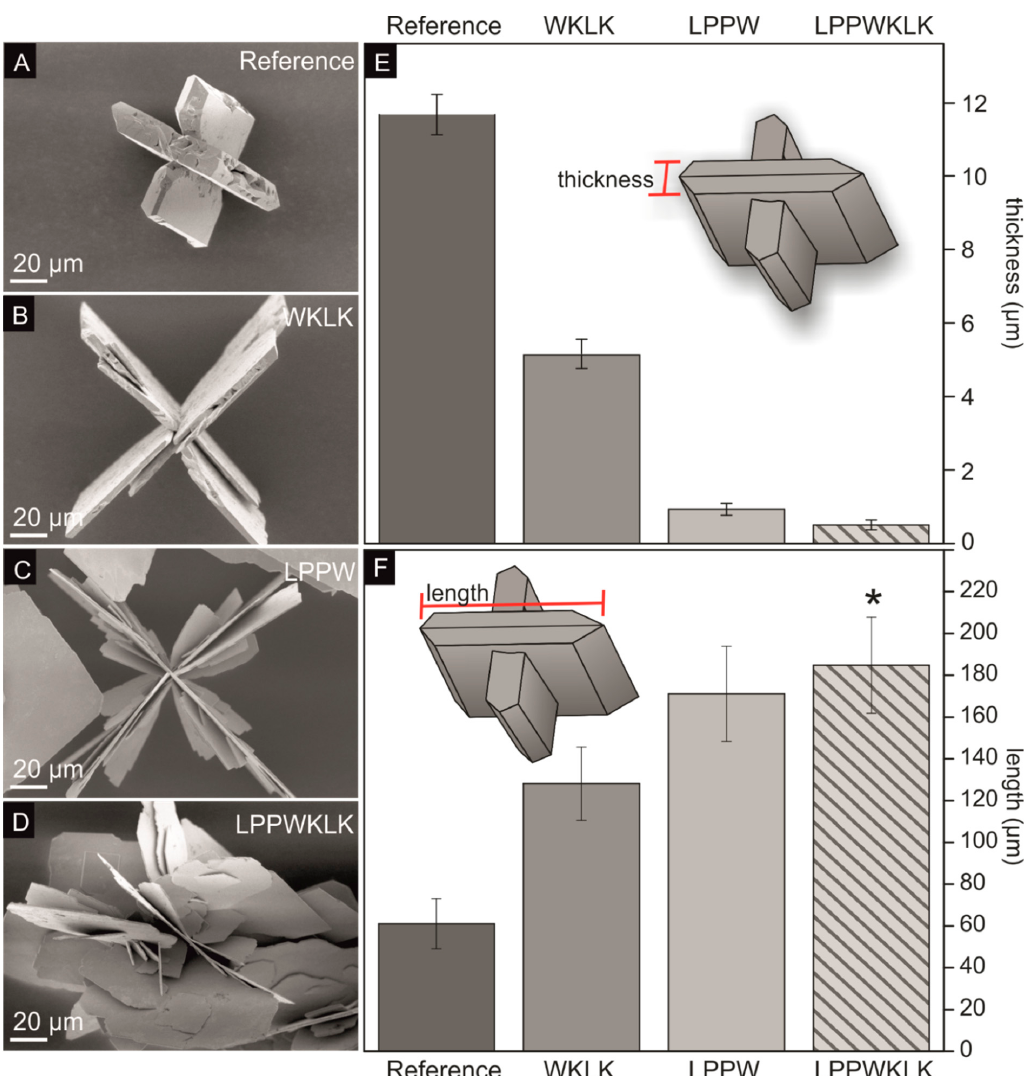
Figure 2. Results of the SnO microstructure synthesis in the presence of the peptide SnBP01 and the peptide segments p-01-1 and SnBP01-2. Scanning electron microscopy (SEM) images of the different SnO morphologies synthesized with ( A ) no peptide, ( B ) SnBP01-2, ( C ) SnBP01-1, and ( D ) SnBP01. The corresponding platelet thickness of the structures is shown in ( E ), and the platelet length in ( F ). * Due to the irregular structure of the flower-like SnO particles, the longest continuous platelet of each particle was measured. Table 3. Thickness, length, and aspect ratio of the synthesized SnO